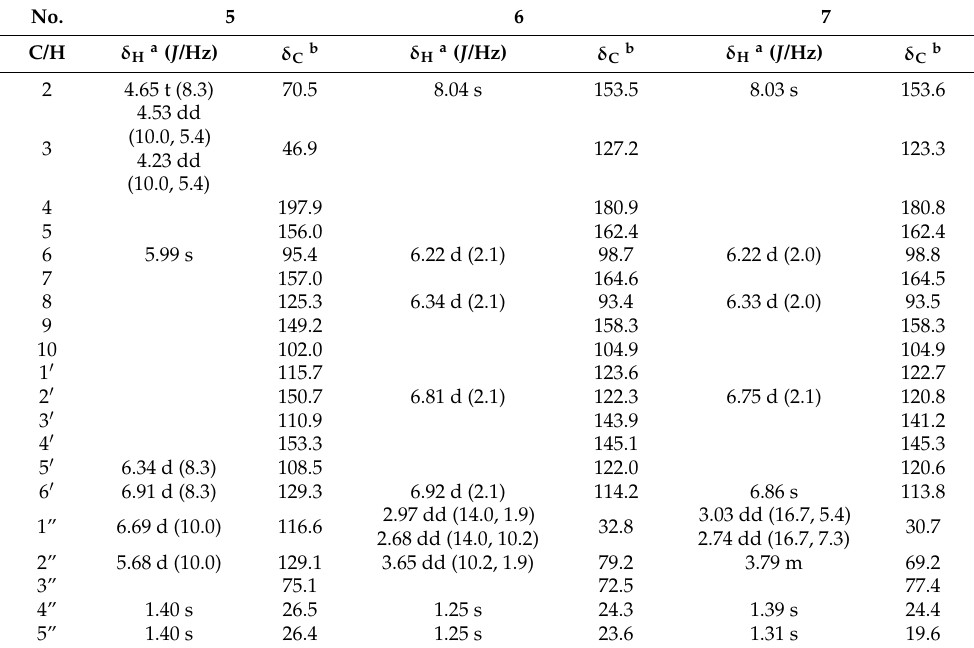
Table 1. 1 H- and 13 C-NMR data for 5 – 7 in CD 3